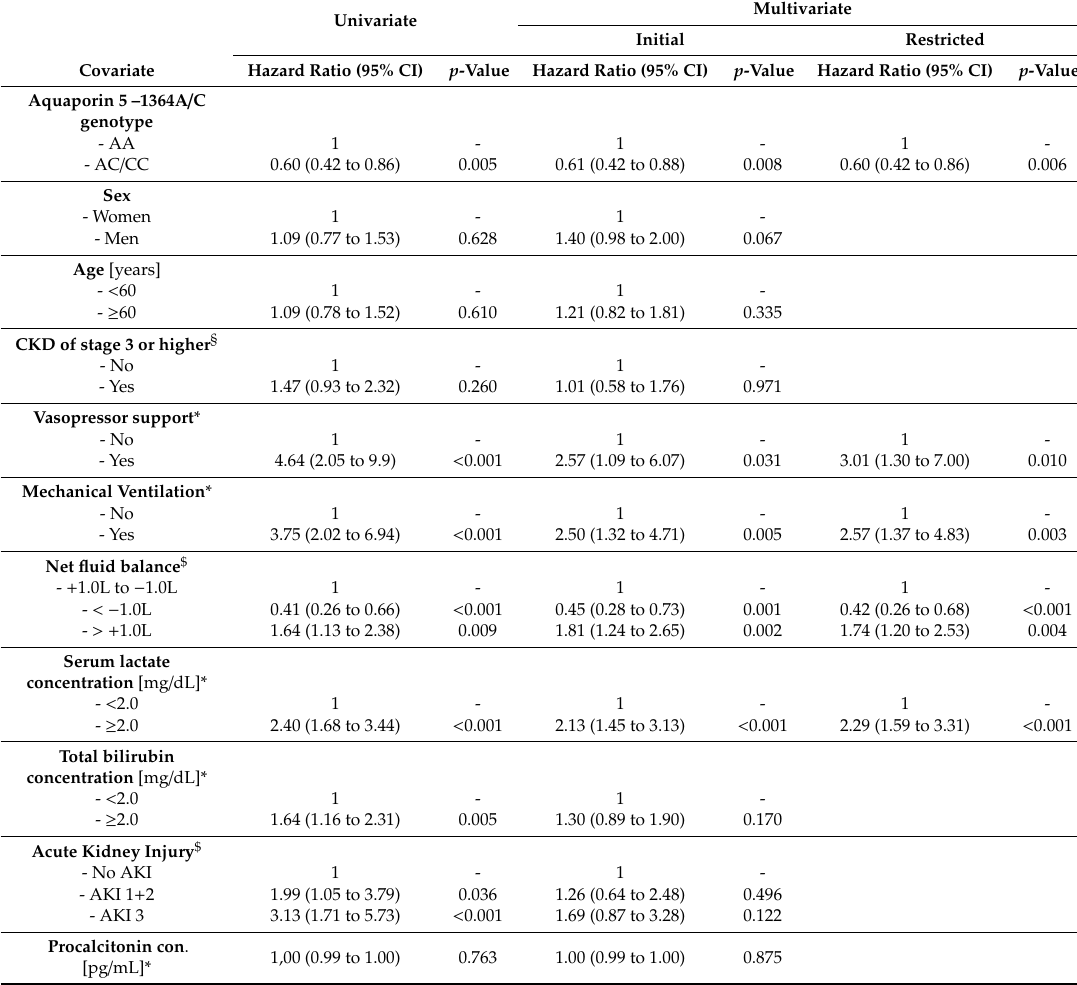
Table 2. Cox regression analysis assessing the association of variables with 90-day mortality in patients with sepsis (n =